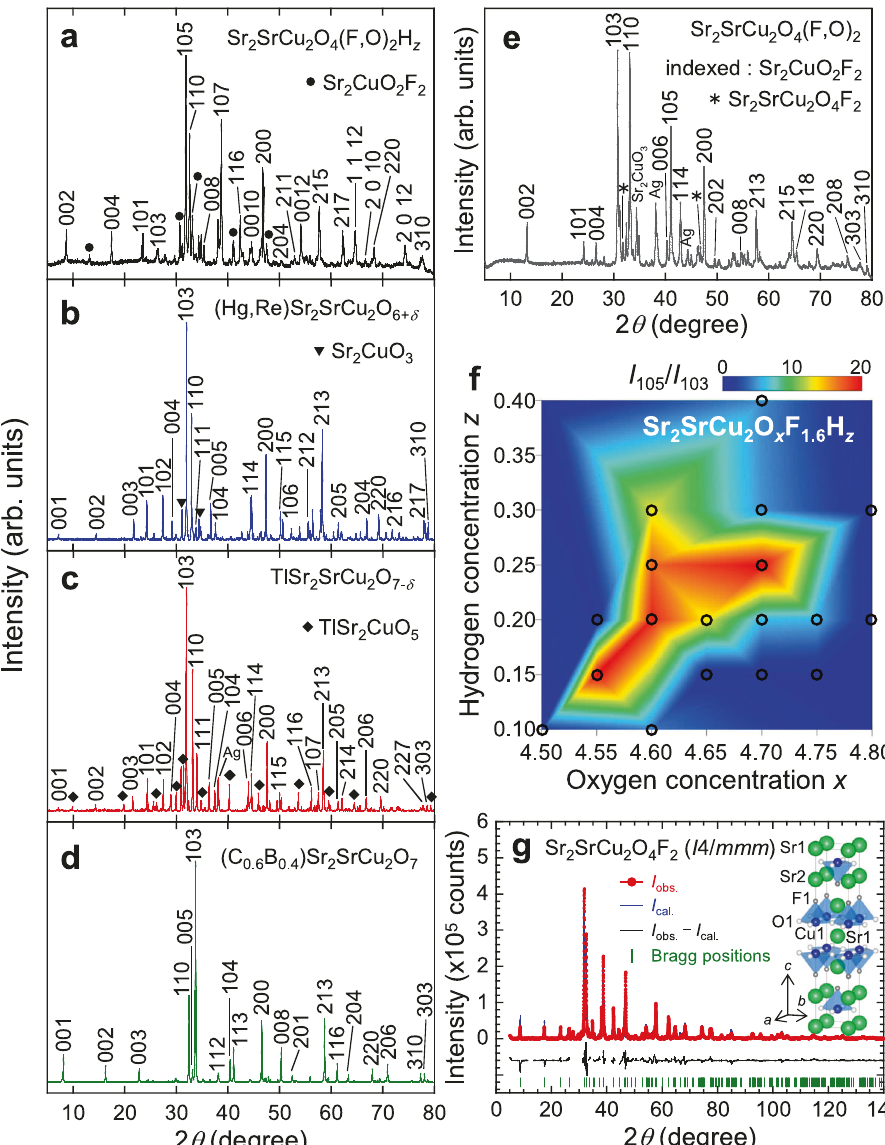
Fig. 1 Phase formation of Ca-free double-layered cuprates. a – d Powder X-ray diffraction (XRD) patterns of as-synthesized a 0212-F, b (Hg,Re)-1212, c Tl-1212, and d (B,C)-1212 samples with Ae ¼ Ae 0 ¼ Sr. For 0212-F, the sample was synthesized with the addition of a small amount of Sr(OH) 2 as a hydrogen source. The indexed peaks are derived from the tetragonal double-layered phase. The black circle, triangle, and diamond markers represent XRD peaks originating from the impurities Sr 2 CuO 2 F 2 , Sr 2 CuO 3 , and TlSr 2 CuO 5 , respectively. For Tl-1212, the peak originating from Ag is due to the reduction of the oxidizer AgO. e The XRD pattern of an as-synthesized sample with the starting composition of Sr 2 SrCu 2 O 4.4 F 1.6 without adding hydrogen. The peaks coming from 0201-F (Sr 2 CuO 2 F 2 ) are indexed, and those indicated by the black asterisk originate from the 0212-F phase. f Relationship between the oxygen ( x ) and hydrogen ( y ) concentrations in the nominal composition of Sr 2 SrCu 2 O x F 1.6 H z . The contour plot indicates the XRD intensity ratio between the (105) and (103) peaks of the 0212-F and 0201-F phases, respectively. The warmer the color, the more predominant the formation of the 0212-F phase within the bulk sample. The veri fi ed composition point is represented by an open circle. g Rietveld analysis results for the tetragonal I 4/ mmm phase of 0212-F with the starting composition of Sr 2 SrCu 2 O 4.6 F 1.4 H 0.2 . The observed and calculated XRD patterns are represented by I obs. and I cal. , respectively. A difference curve ( I obs. − I cal. ) and Bragg positions ( ∣ ) are shifted appropriately along the y -axis to improve visibility. The partial lack of I cal. and the difference data is due to the elimination of impurity-derived peaks, as we performed single-phase analysis. The chemical composition, Sr 2 SrCu 2 O 4 F 2 , was